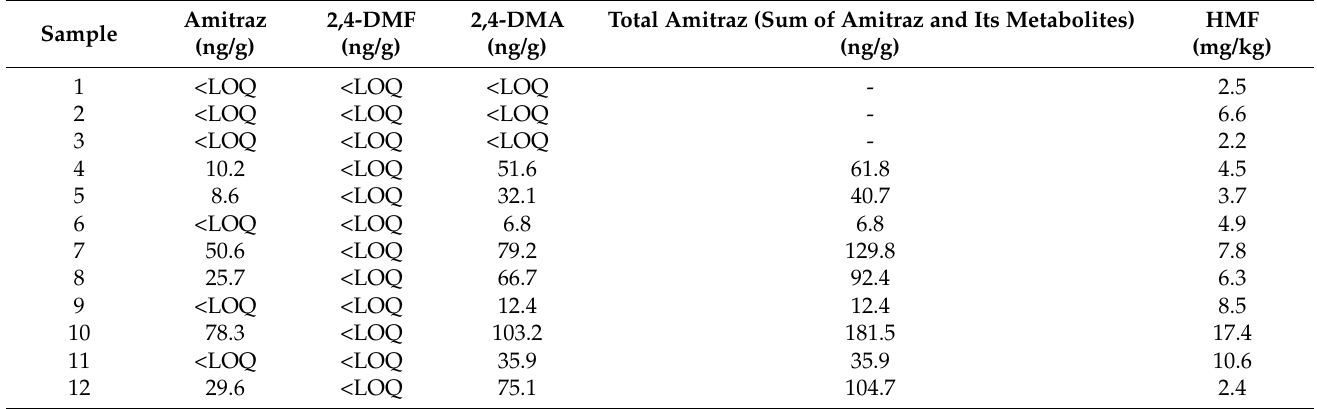
Table 3. Determination of pesticides (amitraz, 2,4-DMF and 2,4-DMA) and hydroxymethylfurfural (HMF) in analyzed honey